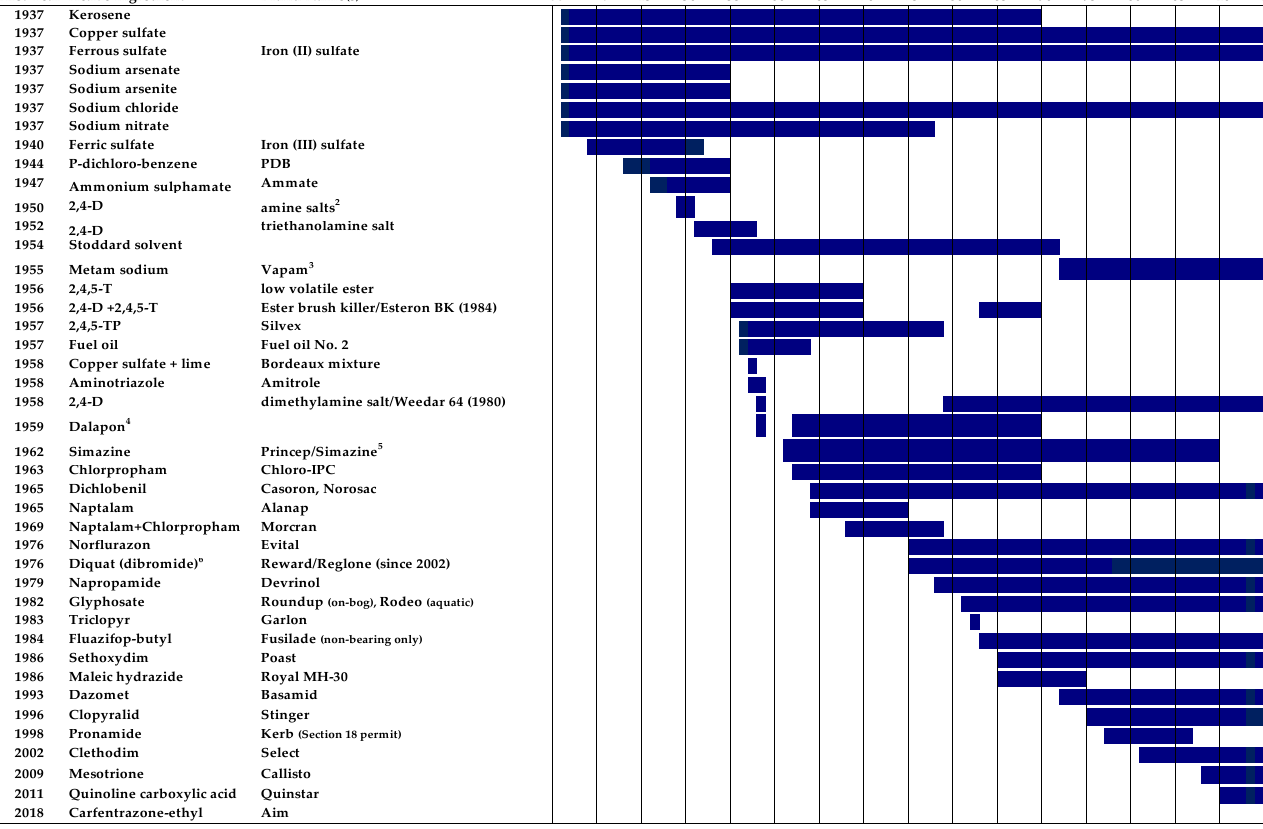
Figure 1. Historical listing of herbicides registered for use in cranberries, 1937–2018. Bar indicates years recommended and/or labeled for use; data derived from Massachusetts-based documents and personnel1. Although charts were not printed during 1942–1945, it is presumed that the compounds registered for use on cranberry remained registered during these World War II